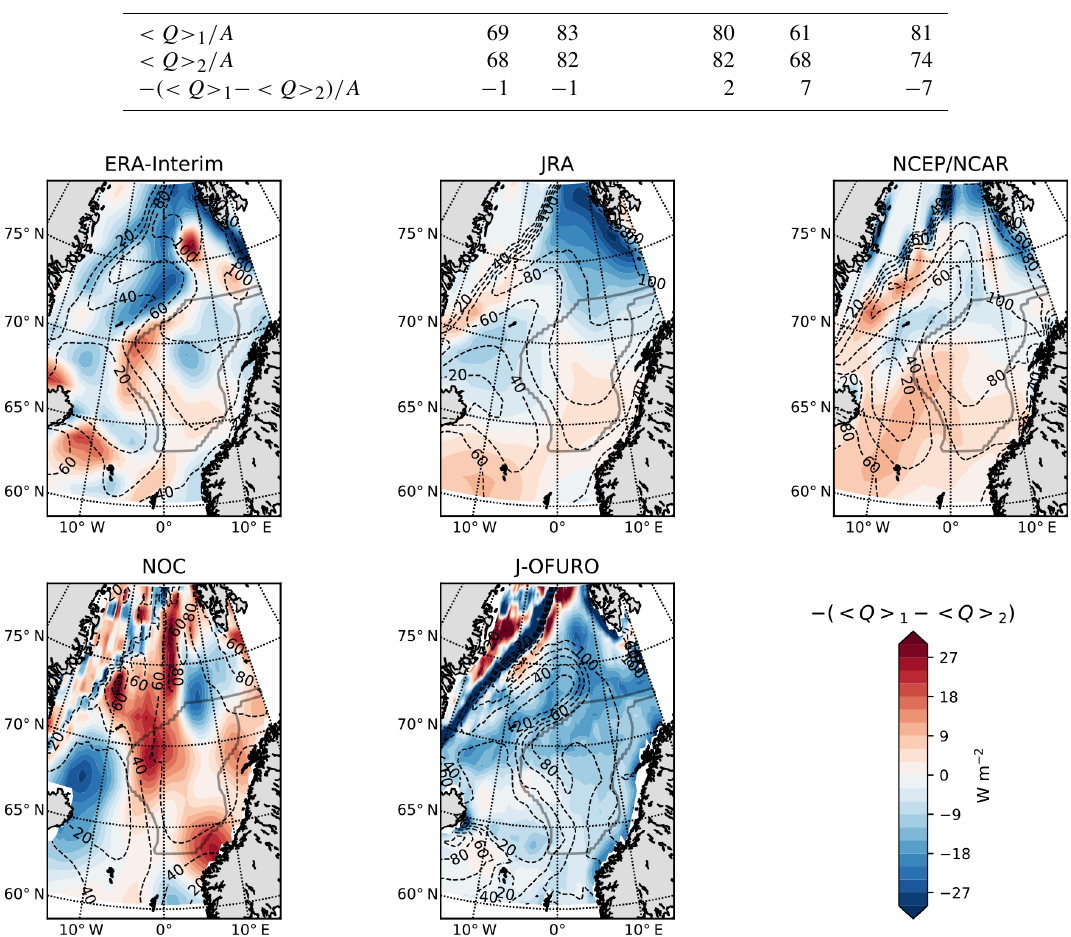
Figure 5. Net surface heat flux Q (Wm − 2 ), defined positive upwards, for five different products (ERA-Interim, JRA-55, NCEP/NCAR, NOC Surface Flux Dataset and J-OFURO). Shading represents the difference between the periods 1993–2002 and 2004–2013, i.e. − (< Q> 1 − < Q> 2 ) , overlaid by the climatological mean net surface heat flux 1993–2013 (dashed contours). The solid grey line depicts the AW domain (cf. Fig.